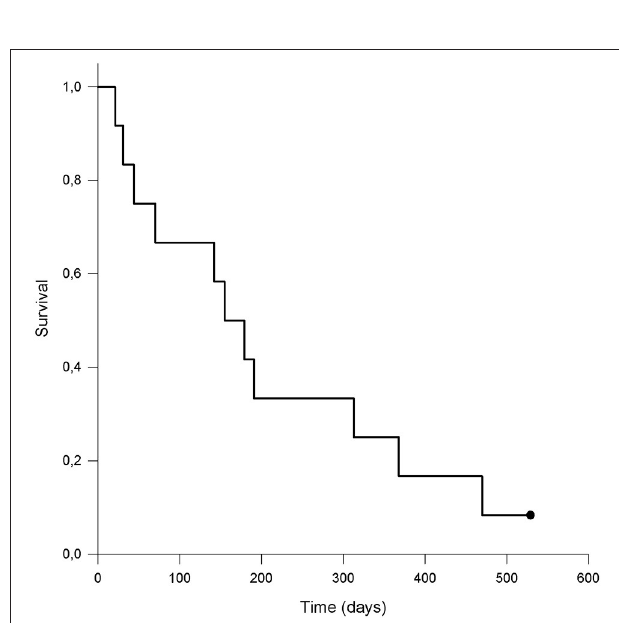
FIGURE 3 | Kaplan-Meier survival curve of dogs (n = 12) with malignant oral tumors treated with metronomic chemotherapy with cyclophosphamide. The dot represents a patient that was alive at the end of observation period and was censored from the analysis. The calculated median survival time (MST) was 155